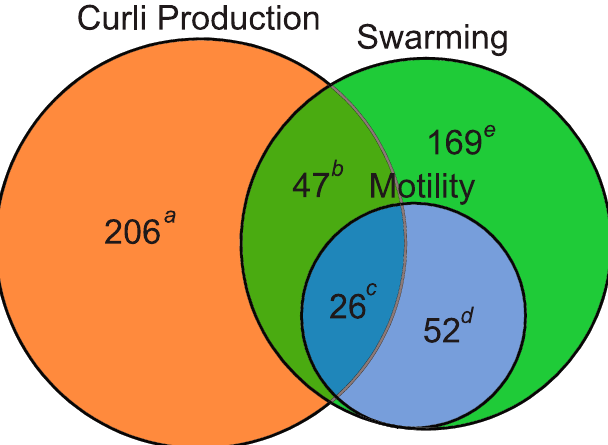
Figure 6. Venn diagrams demonstrating few genes associated with curli affect swarming or swimming. Comparison of genes found to affect curli with swimming and swarming associated genes. Sections of Venn diagrams: a (orange), curli associated genes that do not affect swarming or swimming motility; b (dark green), curli associated genes that affect swarming motility; c (dark blue), curli associated genes that affect swimming motility; d (light blue), swimming defective genes that do not affect curli; and e (light green), swarming defective genes that do not affect curli. See Table S7 for complete list of genes.